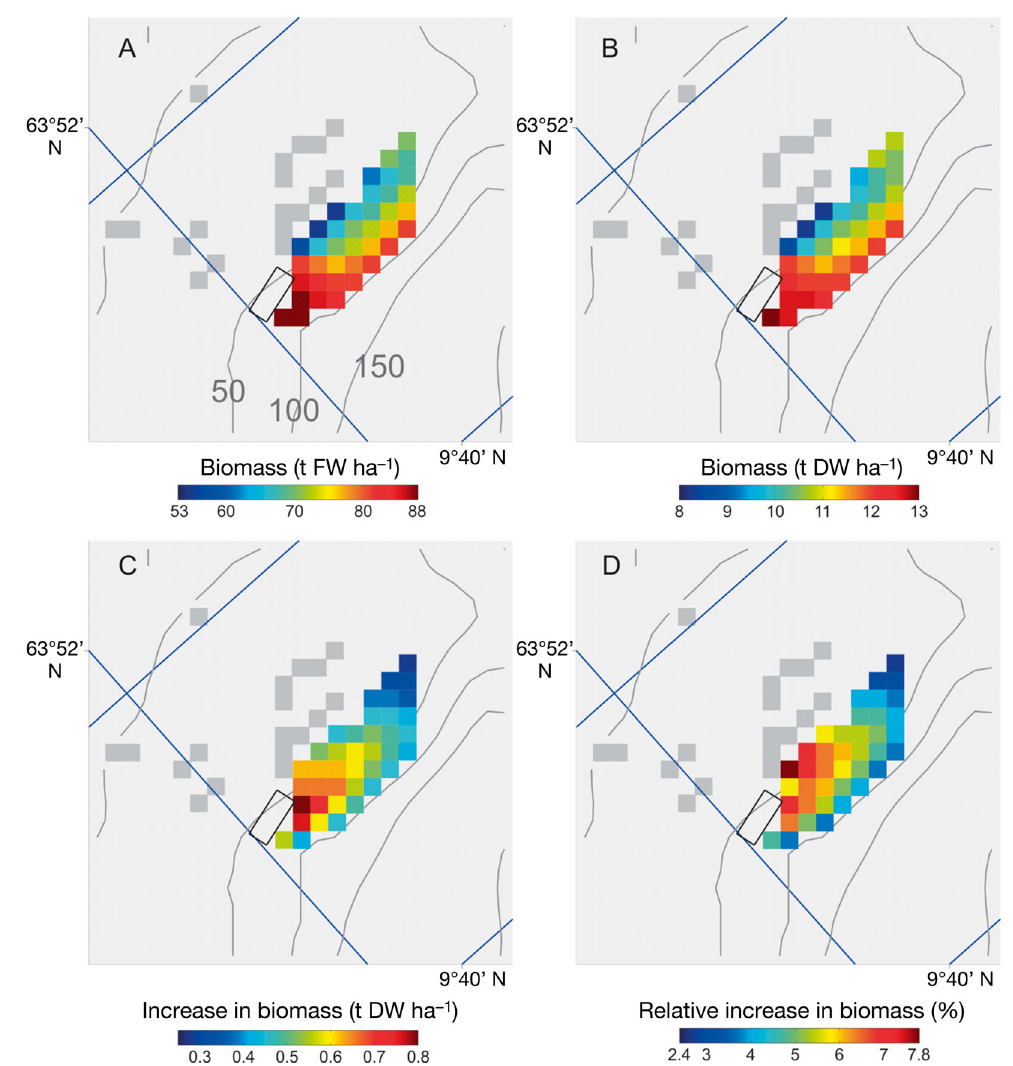
Fig. 15. Saccharina latissima . Simulation of a 100 ha S. latissima farm (coloured squares) adjacent to the fish farm, the mooring frame of which is outlined as a black rectangle. Horizontal grid resolution is 160 m; dimensions of the mooring frame are 200 × 500 m. Grey curves are 50, 100 and 150 m isobaths. Deployment on 21 February, harvest on 15 June. (A) S. latissima fresh weight (FW) biomass, Simulation D Feb,N . (B) S. latissima dry weight (DW) biomass, Simulation D Feb,N . (C) Increase in S. latis- sima DW biomass from Simulation D Feb to D Feb,N . (D) Relative increase in S. latissima DW biomass from Simulation D Feb to D Feb,N (%). Dark grey regions indicate land. See Table 2 for details on